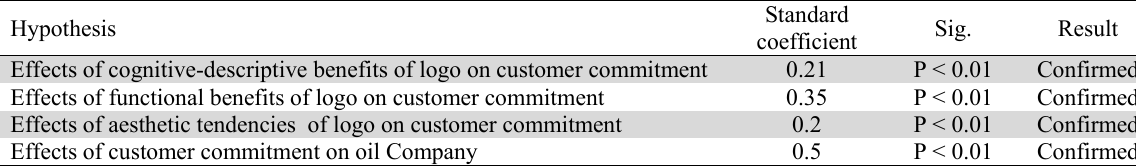
Standard Sig. Result coefficient